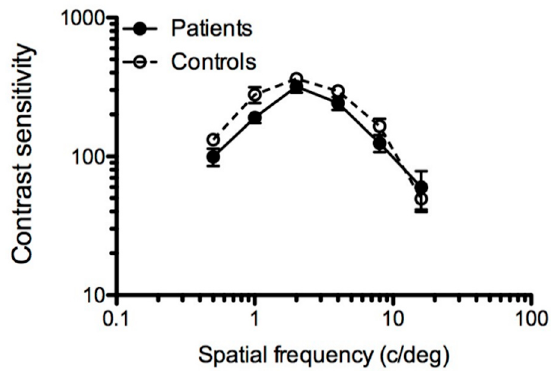
Figure 1. Spatial contrast sensitivity functions (0.5 to 16 c/deg) for the myalgic encephalomyelitis (ME) group (closed symbols) and controls (open symbols). Error bars represent ±1 S.E.M.